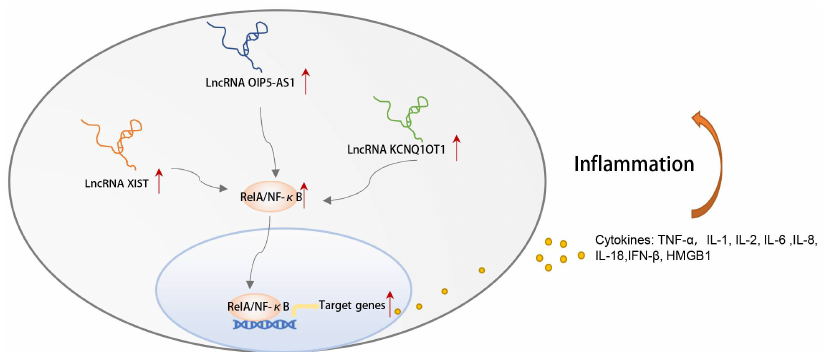
Figure 9. The sketch map of lncRNAs in the ceRNA networks activating the NF-κB signal pathway and inflammation based on the literature research. Red arrows indicate that the expression levels of the gene are elevated.